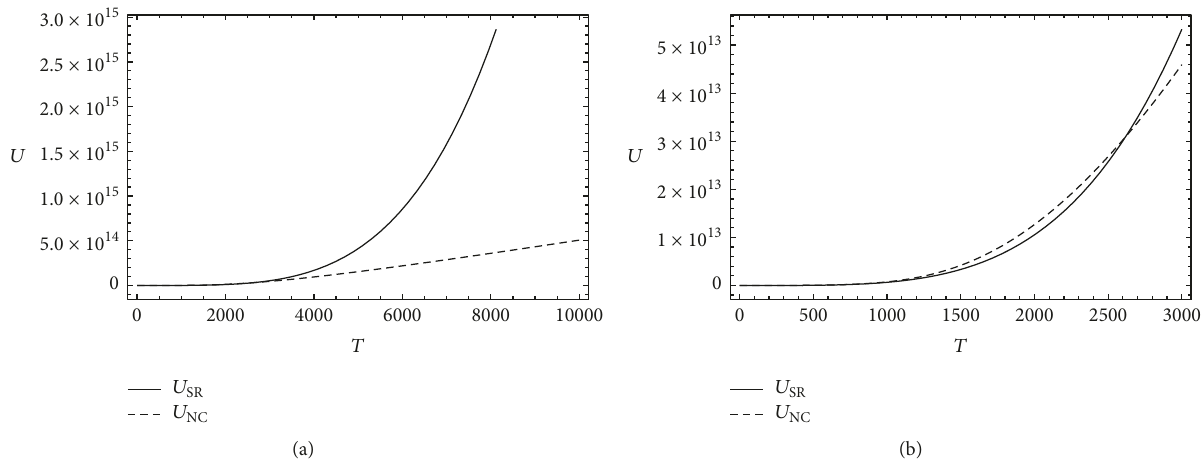
Figure 1: Plot (a) of internal energy 𝑈 of photon gas against temperature 𝑇 for both the SR theory and the NC model. The dashed line corresponds to the NC model, and the solid line represents the corresponding quantity SR theory. The NC model results have been obtained numerically using Mathematica [35]. We have used the Planck units, and the corresponding parameters take the following values: 𝜅 = 10000 , 𝑘 = 1 , 𝑉 = 1 , ℎ = 1 , and 𝑐 = 1 . In this scale, 𝑇 = 10000 K is the Planck temperature, 𝑇 𝐵 𝑃 (the plotting style has been adopted from [24]). Plot (a) is done for the entire temperature range, that is, from zero temperature to Planck temperature. But in plot (b) we have plotted the internal energy in a range from 𝑇 = 0 to 𝑇 = 3000 K so that it becomes clear where two graphs intersect each other.